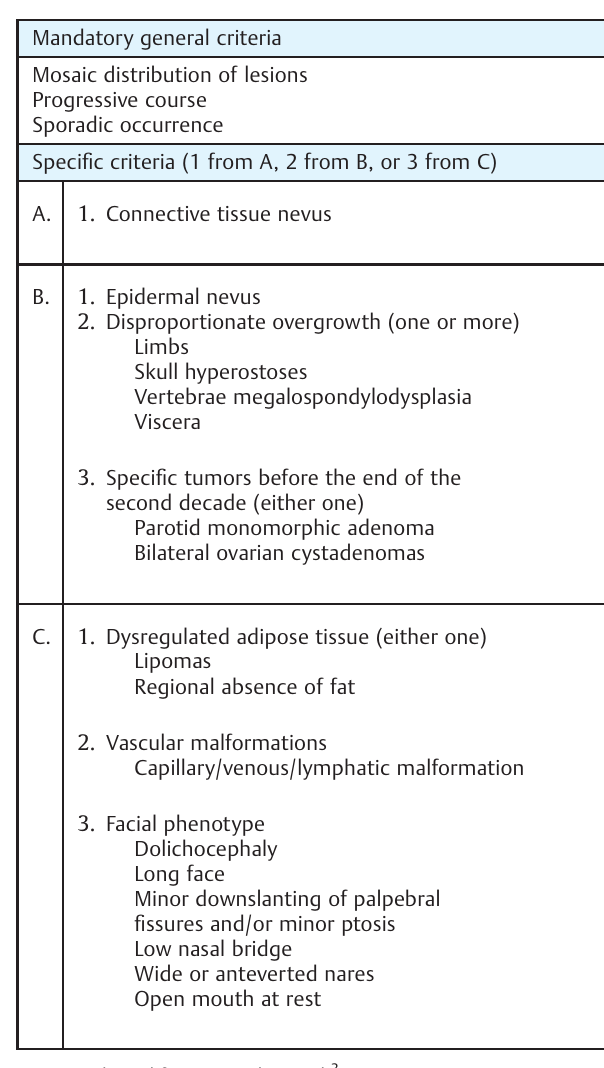
Table 1 Proteus